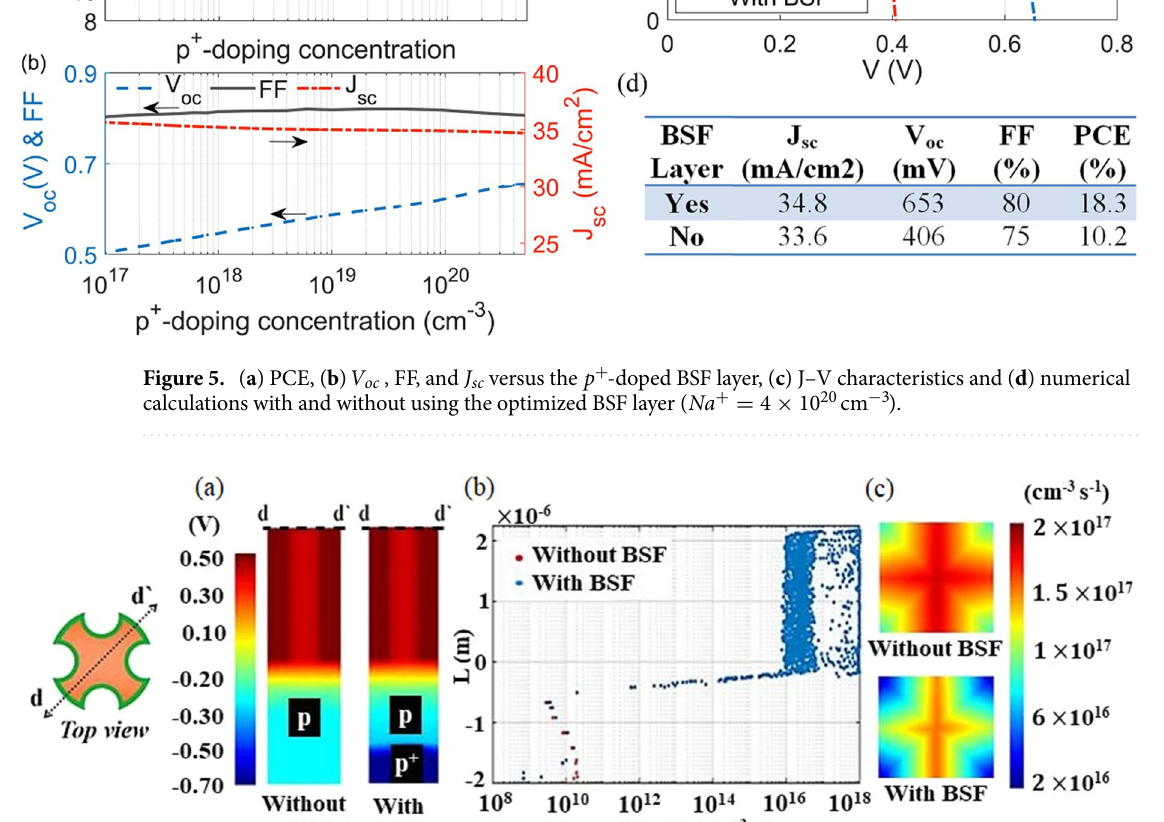
Figure 6. ( a ) Electric potential profile, ( b ) n-carrier concentration density, and SR rate ( c ) at the back surface metal layer, and with (right) and without (left) using the optimized BSF layer. This image is created by Lumerical 2020a, FDTD Solver Version 8.23.2305, https:// www. lumer ical. com (license number-12802) released to Zewail City of Science and Technology, Giza,